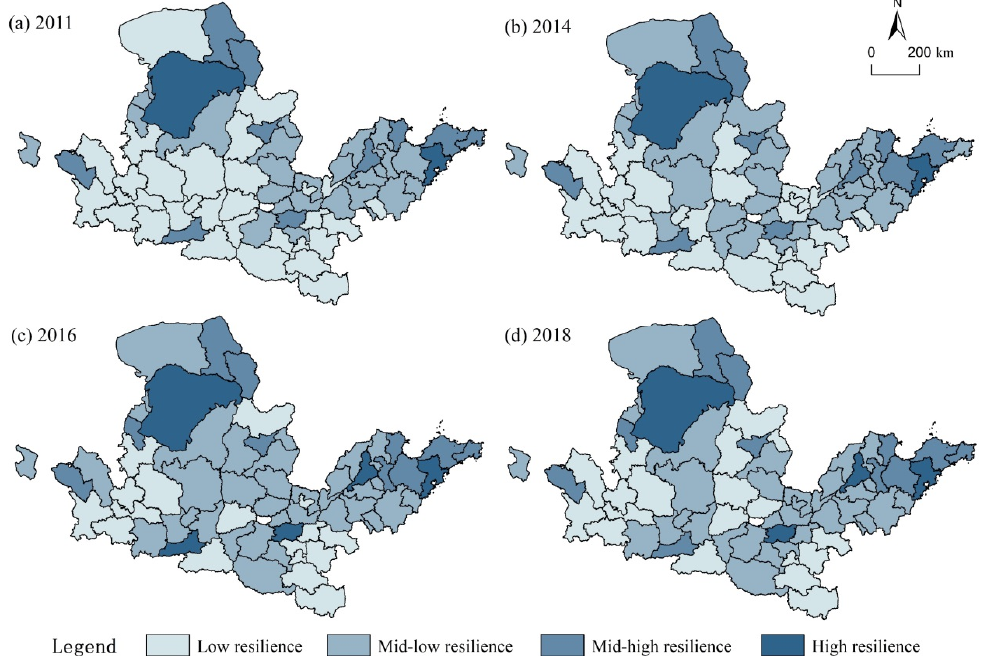
Figure 3. The spatial distribution of URI in the YRB from 2011 to 2018.